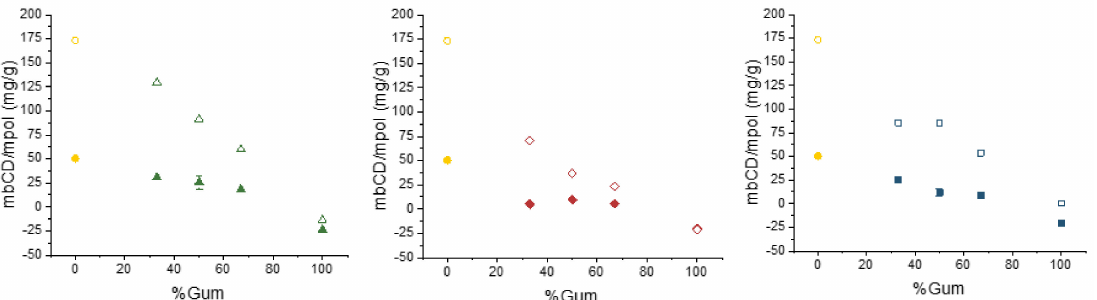
Figure 4. Amount of available cyclodextrin (mg / g) as a function of the cyclodextrin / gum hydrogel composition for xanthan gum ( left ), locust bean gum ( center ) and chitosan ( right ). Filled symbols, insoluble fractions; empty symbols, soluble fractions. (Error bars for 50% insoluble fractions obtained with n = 5